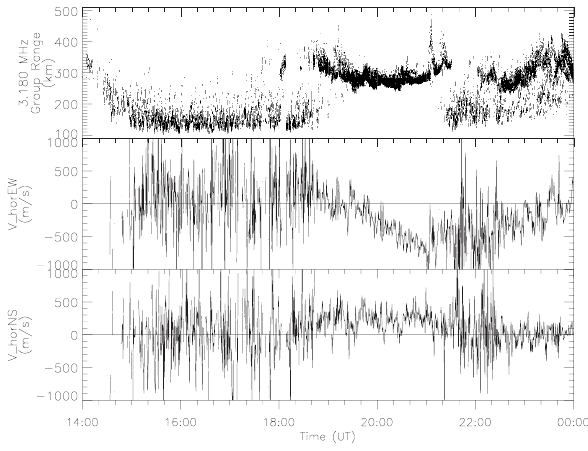
Figure 2. Midday ionospheric measurements from Cambridge Bay, 18 Dec. 1995. Panels are the same as Figure 1. Fig. 2. Midday ionospheric measurements from Cambridge Bay, 18 December 1995. Panels are the same as Fig. 1.